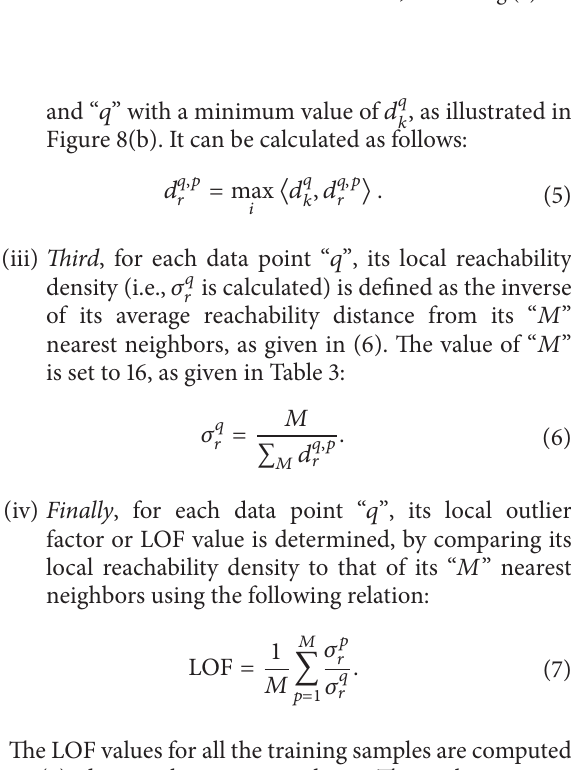
Figure 8: For 𝑘 = 3 , calculating (a) the k -distance and (b) the reachability distance.